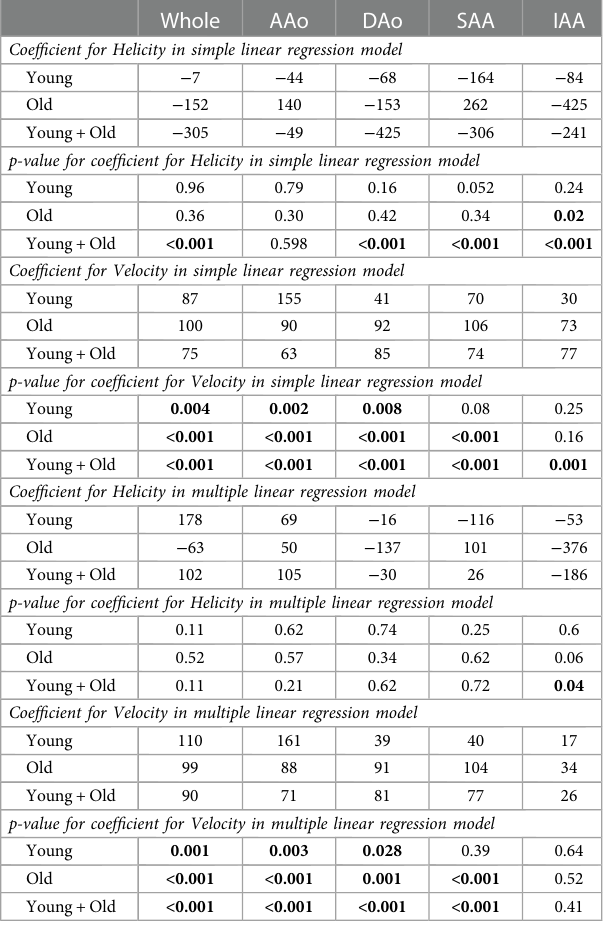
TABLE 4 Results from simple and multiple linear regression for the prediction of turbulent kinetic energy (TKE) in the aorta.